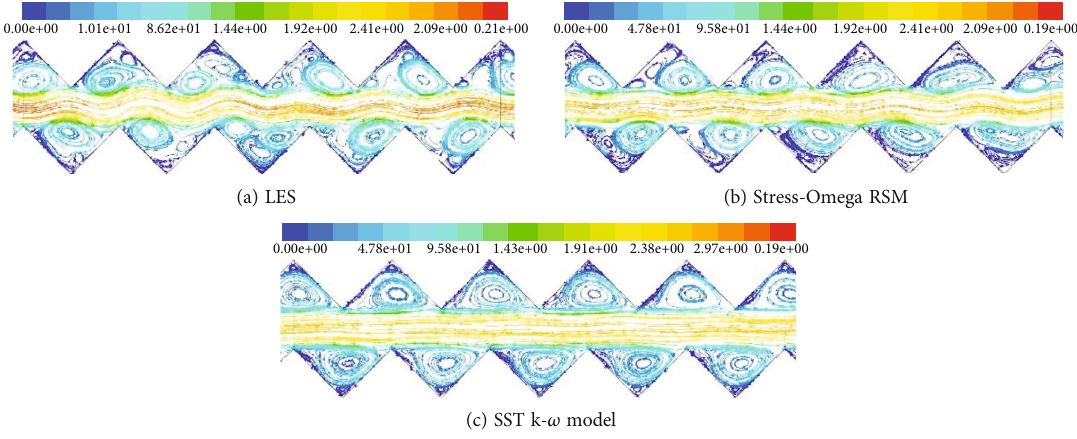
Figure 8: Streamline diagrams when t = 0 : 1 s .